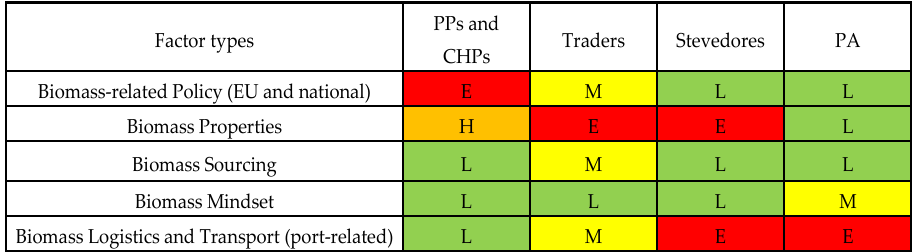
Figure 6. Evaluation of the relevance of the identified factor groups for decisions made by stakeholders of biomass sea-based supply chains.